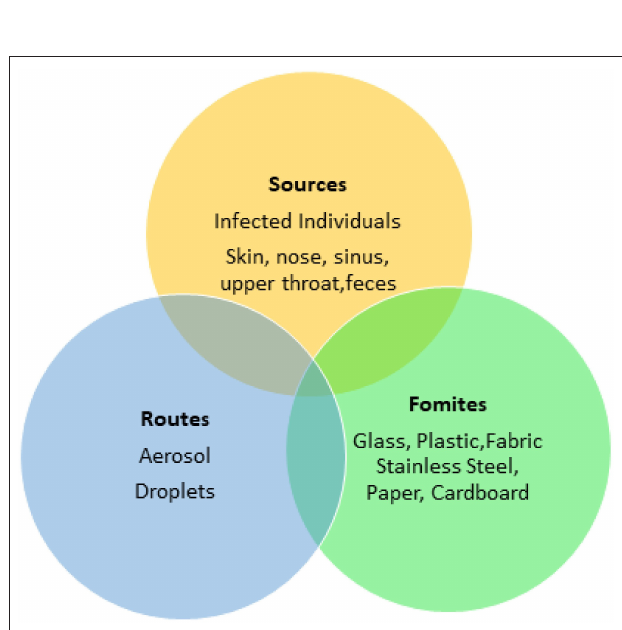
FIGURE 3 | SARS-CoV-2 contagion